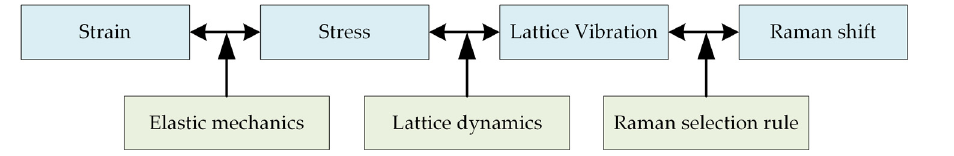
Figure 5. Theoretical framework of the Raman shift–stress relationship model.